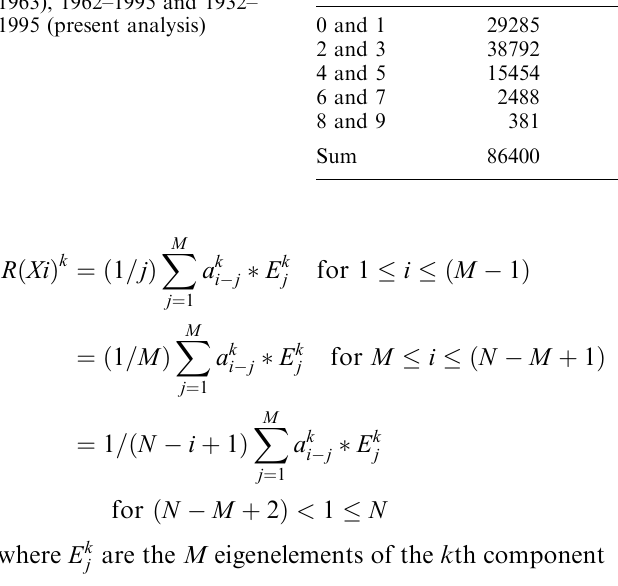
Table 1. Frequencies of Kp indices covering the periods 1932–1961 ( a from Bartels,